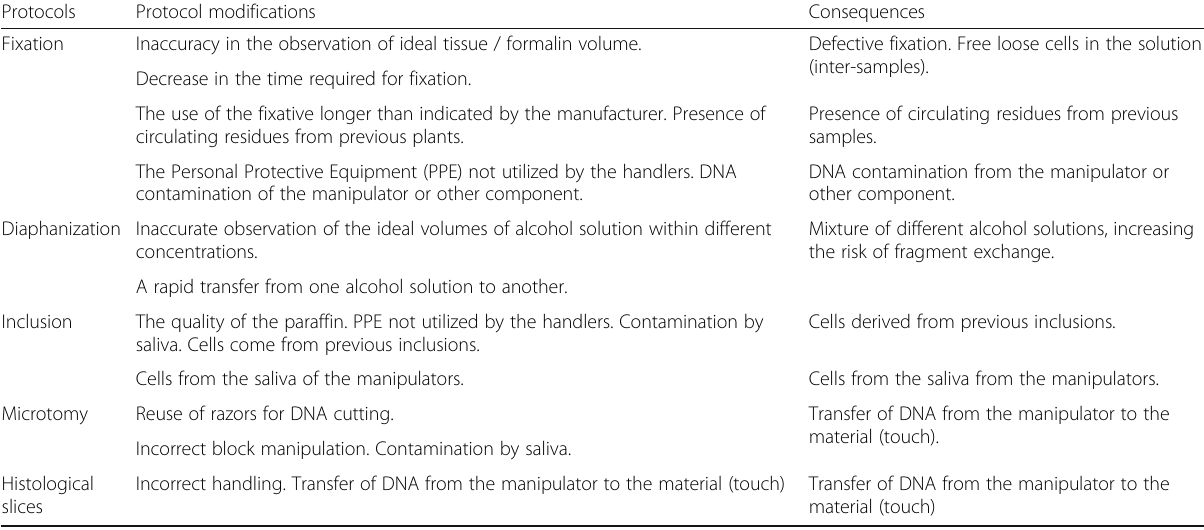
Table 2 Main modifications occurring in the protocols of fixation, inclusion, diaphanization and microtomy that can lead